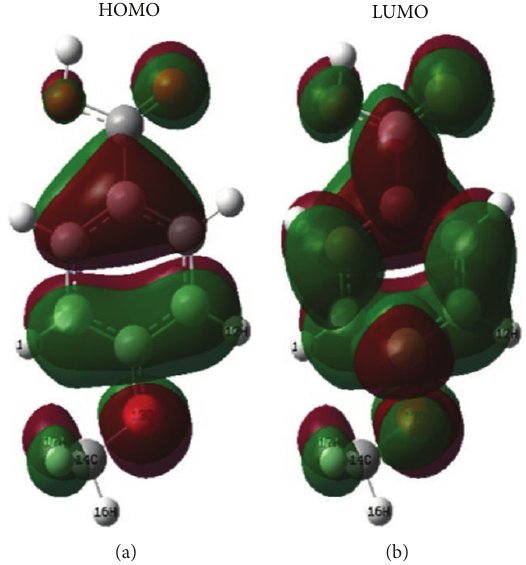
Figure 7: Contour surfaces of frontier molecular orbitals of Anisic